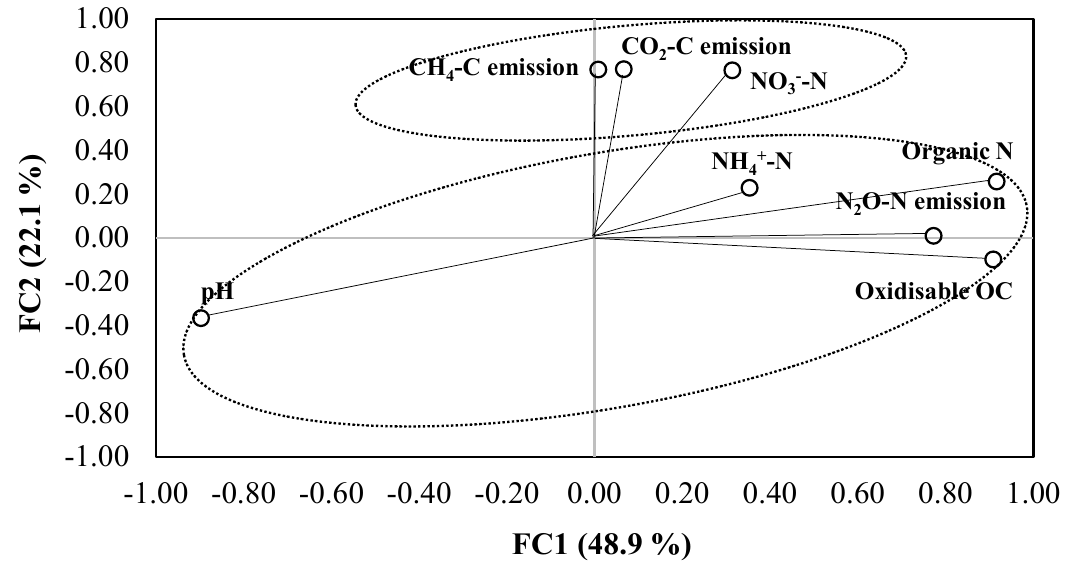
Figure 8. Plot of the first and second factorial components (FCs) extracted by factorial analysis, for the soil parameters and greenhouse gas emissions studied. The ellipses drawn based on statistical tests indicate the parameters grouped in each FC.